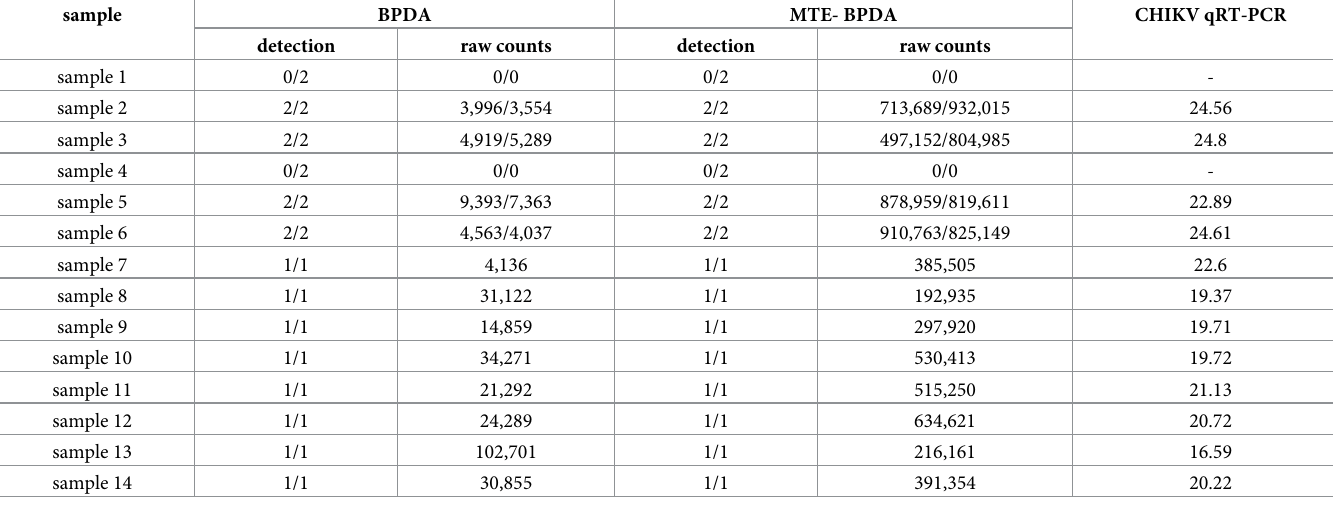
Table 4. Clinical patient sample detection for